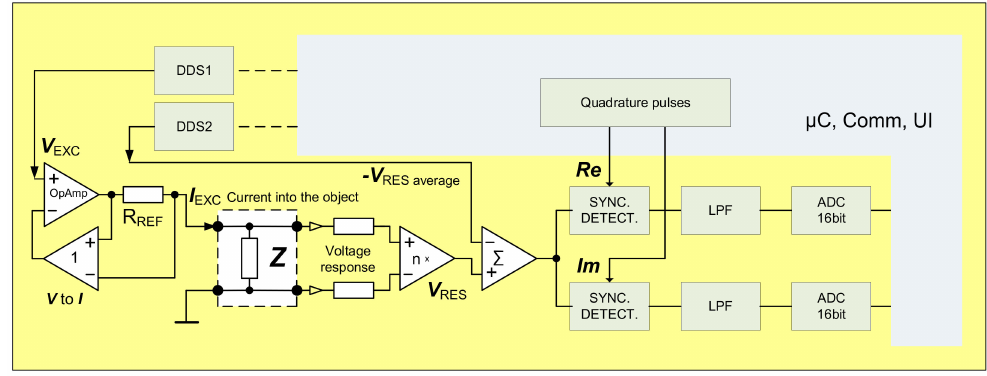
Figure 5. Block diagram of the EBI measurement device using direct carrier compensation